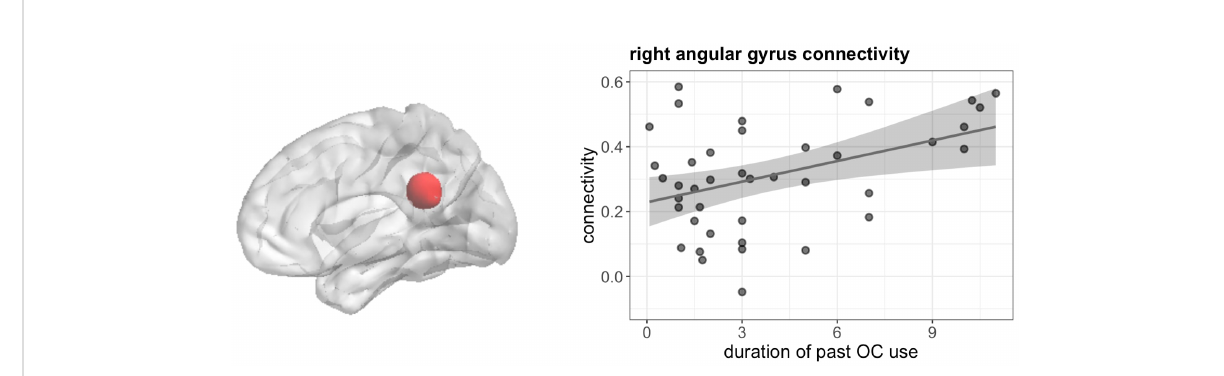
FIGURE 10 Positive association between duration of OC and connectivity between right IFG and right angular gyrus in past users during verbal fl